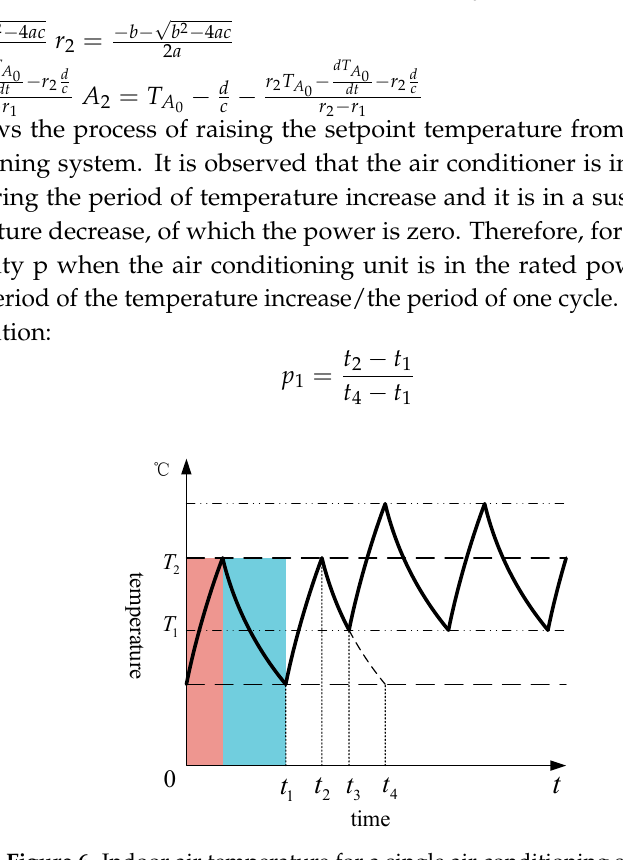
Figure 6. Indoor air temperature for a single air conditioning system.